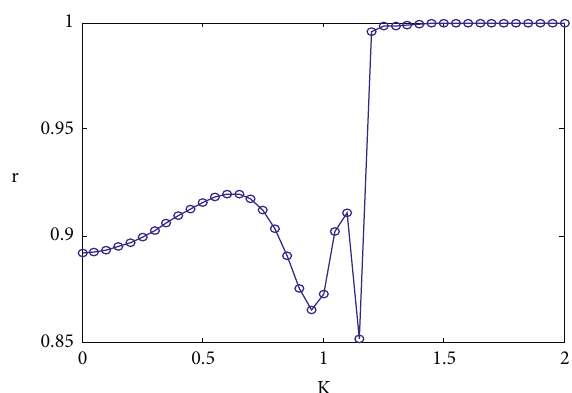
Figure 2: The evolution of order parameter of network with weight parameter c �